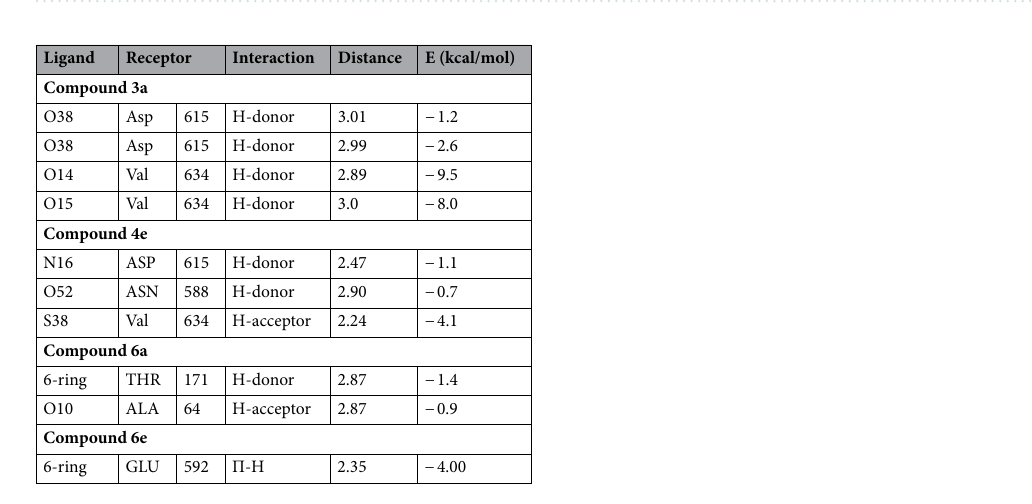
Figure 2. The 2D and 3D binding modes of 4b in the active site of DNA gyrase. H-bonds are represented by blue dashed lines.